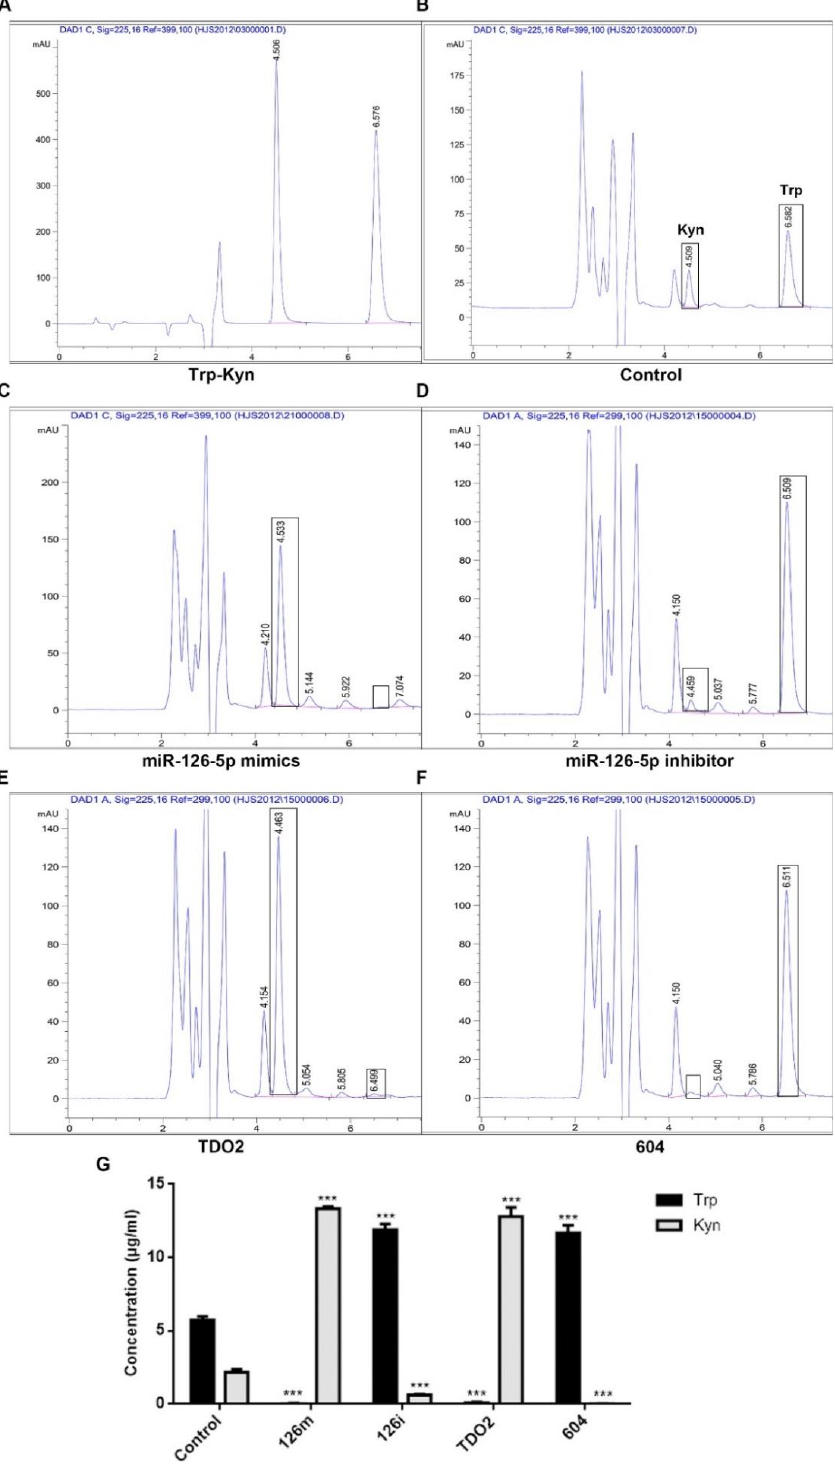
Figure 4. The contents of tryptophan and kynurenine in each group after transfection were deter- mined by HPLC. The X -axis is time (min), and the Y -axis is mAU. The peak at 4.5 min is kynurenine, and the peak at 6.5 min is tryptophan. ( A ) The peak diagram of tryptophan and kynurenine standard. ( B ) The peak diagram of DMEM medium containing 10% FBS. ( C – F ) The peak diagram of cell trans- fection with miR-126-5p mimics, miR-126-5p inhibitor, TDO2 and siRNA-TDO2(604). ( G ) Statistical results of the peak area of each elution peak. Data are shown as mean ± SD, n = 3; *** p < 0.001 vs.